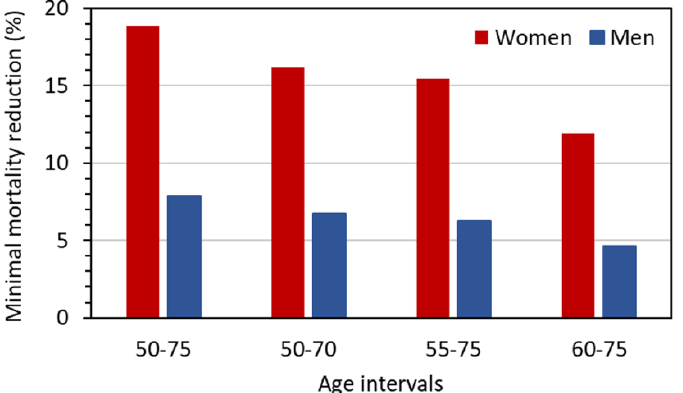
Figure 6. Reduction in lung cancer mortality that must be achieved to attain a benefit–risk ratio of at least 10 assuming annual screening across the given age intervals for a representative LDCT protocol with CTDI vol = 1 mGy.